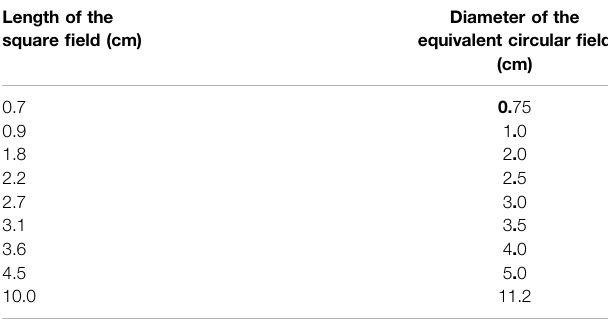
TABLE 1 | The different fi eld sizes used in this study.